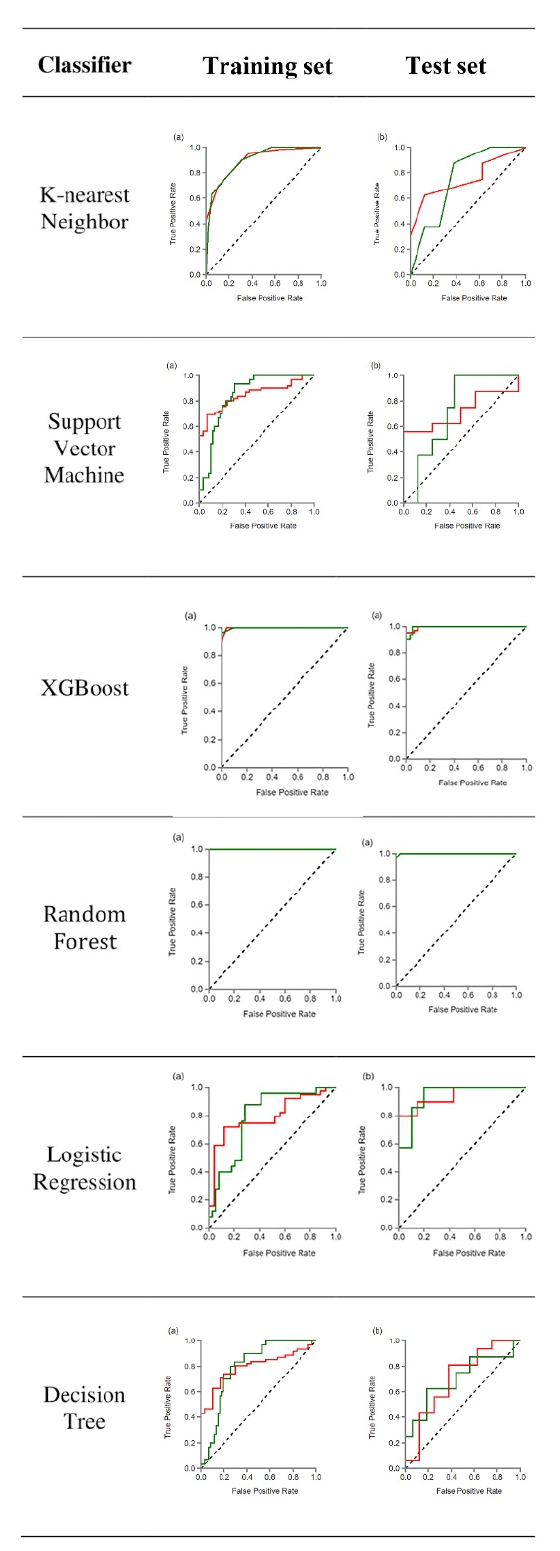
Figure 4. The figure shows the results of the 1st modeling ROC curve analysis for the training and test data for differentiating between PHs and PCTs. Note that green—PHs and red—PCTs. ( a ) ROC curve of the training set and ( b ) ROC curve test set.